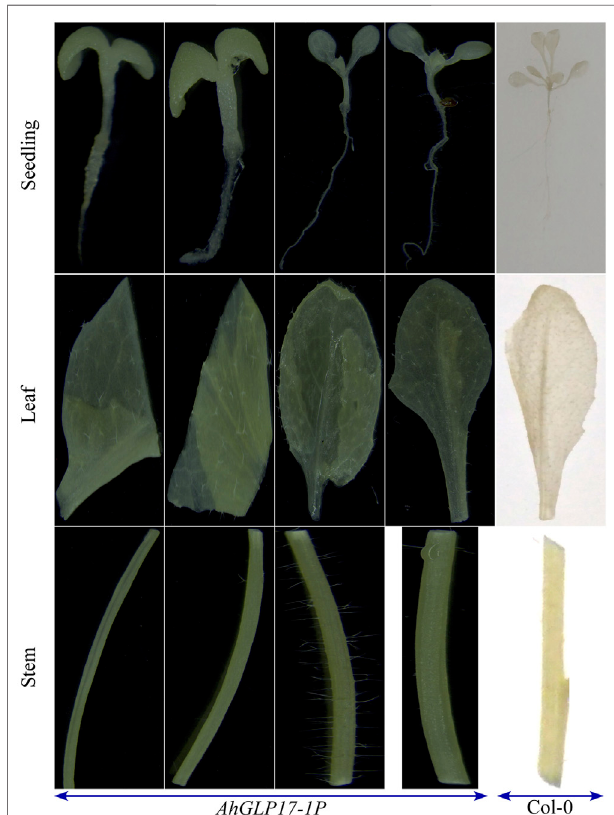
FIGURE 6 | GUS staining of different vegetative tissues of Arabidopsis transgenic plants. AhGLP17-1P plants showed no staining in any vegetative tissue (seedlings, roots, leaf, and stem). Different vegetative tissues of wild- type (Col-0) plants were also used for GUS staining to compare the